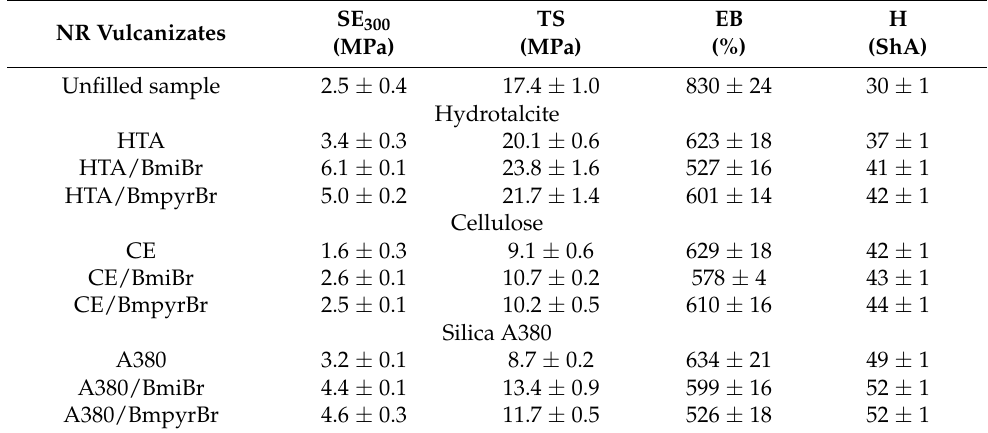
Table 7. Mechanical properties and hardness of NR vulcanizates (SE 300 , stress at 300% relative elongation; TS, tensile strength; EB, elongation at break; H,